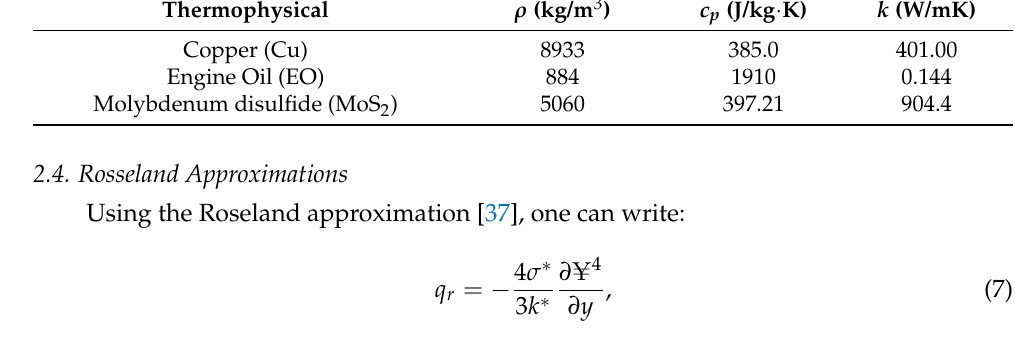
Table 2. Material characteristics of base fluid and nanosolid particles at 293 K.